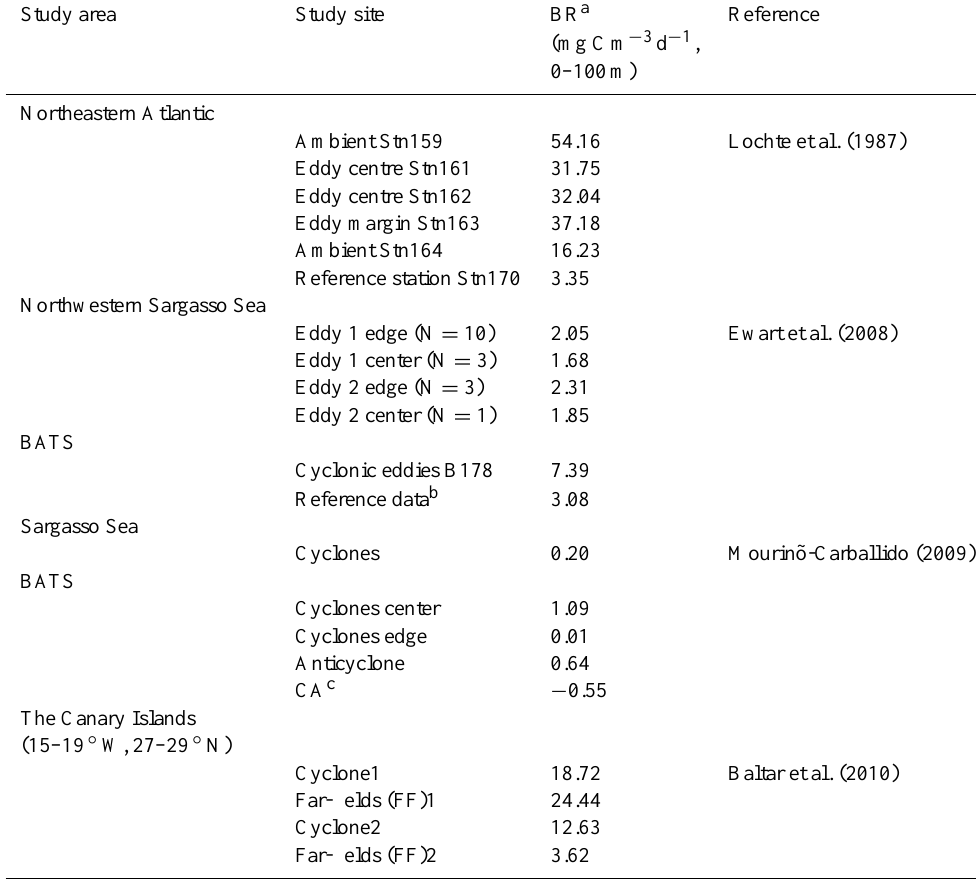
Table 2. Bacterial respiration inside and outside the mesoscale features in the